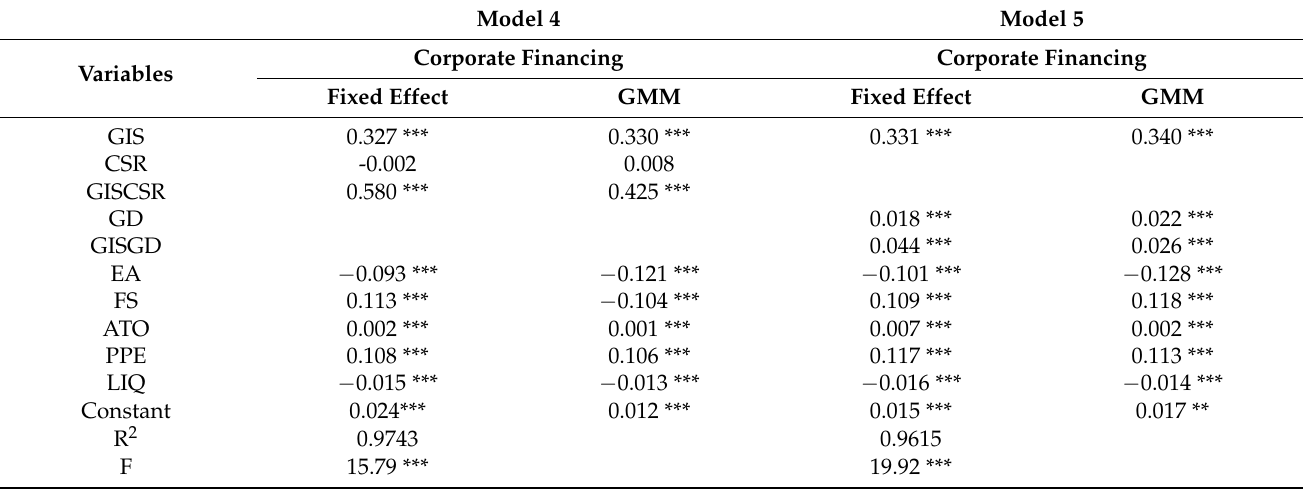
Table 3. The moderating